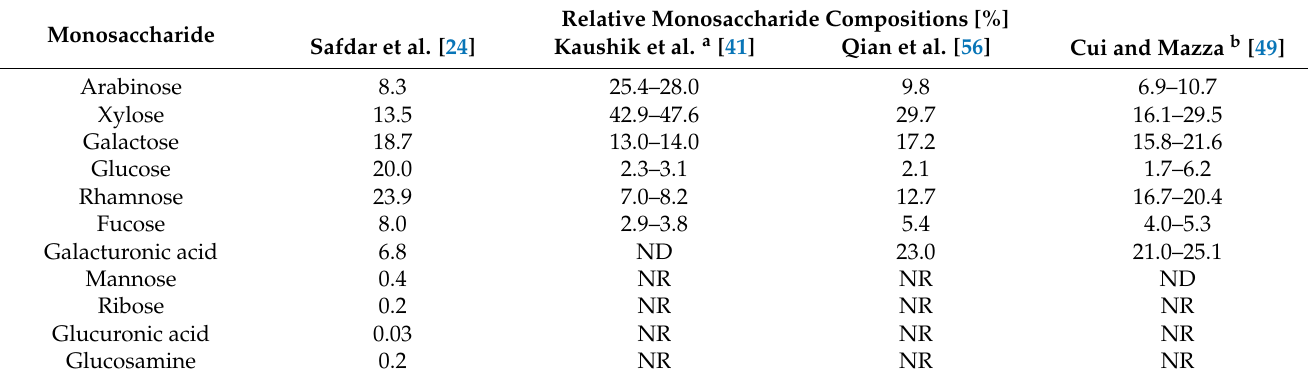
Table 2. Monosaccharide composition of flaxseed